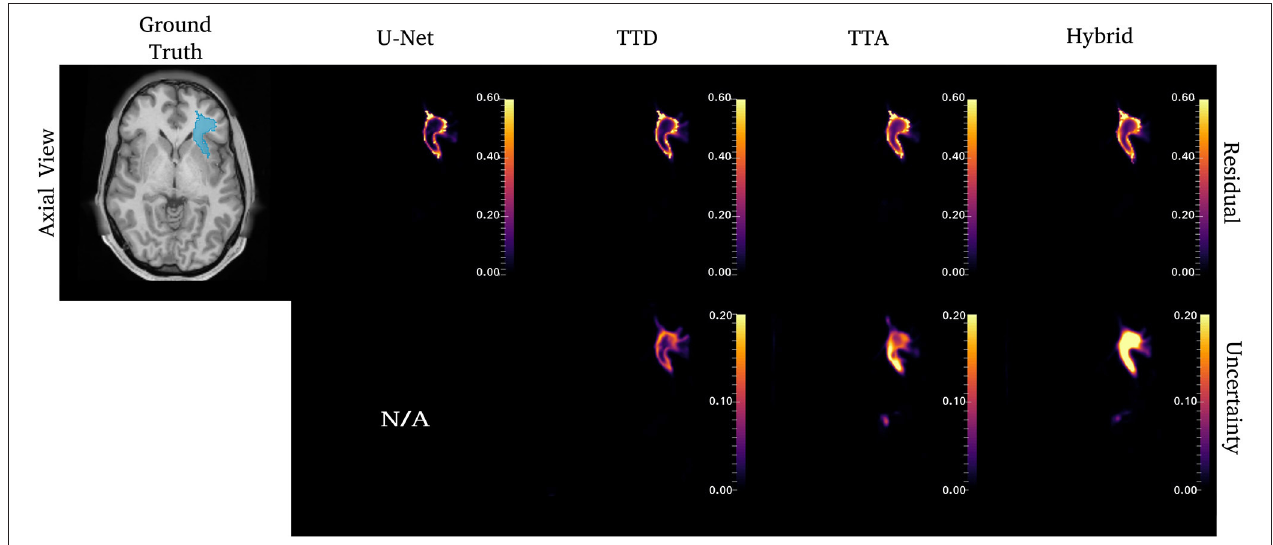
FIGURE 6 | Uncertainty and residual maps for the left UF tract. Uncertainty maps are not applicable (N/A) for the deterministic U-Net